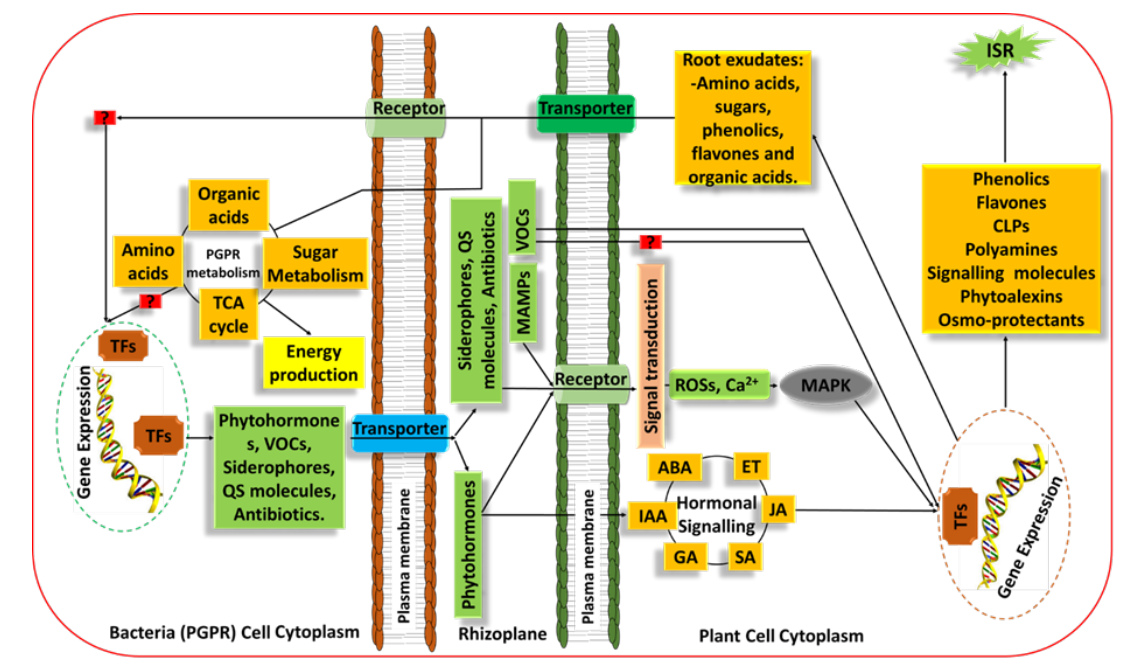
Figure 6. Schematic overview of the symbiotic metabolite exchange during plant – PGPR interactions in the rhizosphere. Plants secrete various organic compounds into the rhizosphere. These compounds are either taken up by the interacting organism for energy production or drive the expression of genes that lead to PGPR-derived compounds (e.g., phytohormones and volatile organic compounds) beneficial to the plant. These compounds are either perceived by the plant membrane receptors, leading to the activation of signalling cascade or diffuse through the membrane to bind to specific transcription factors to induce priming/induced systemic resistance/tolerance (ISR/T). These compounds then modulate the root exudate composition to favour the beneficial PGPR.